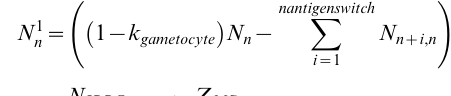
Supporting Information S1 Summary of the computa- tional algorithm per time